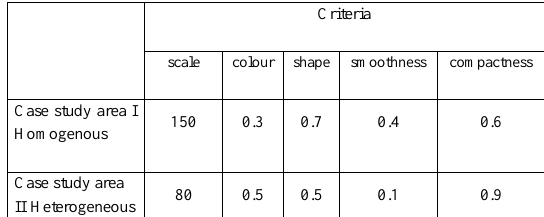
Table 2: Criteria used in segmentation for both case study areas.